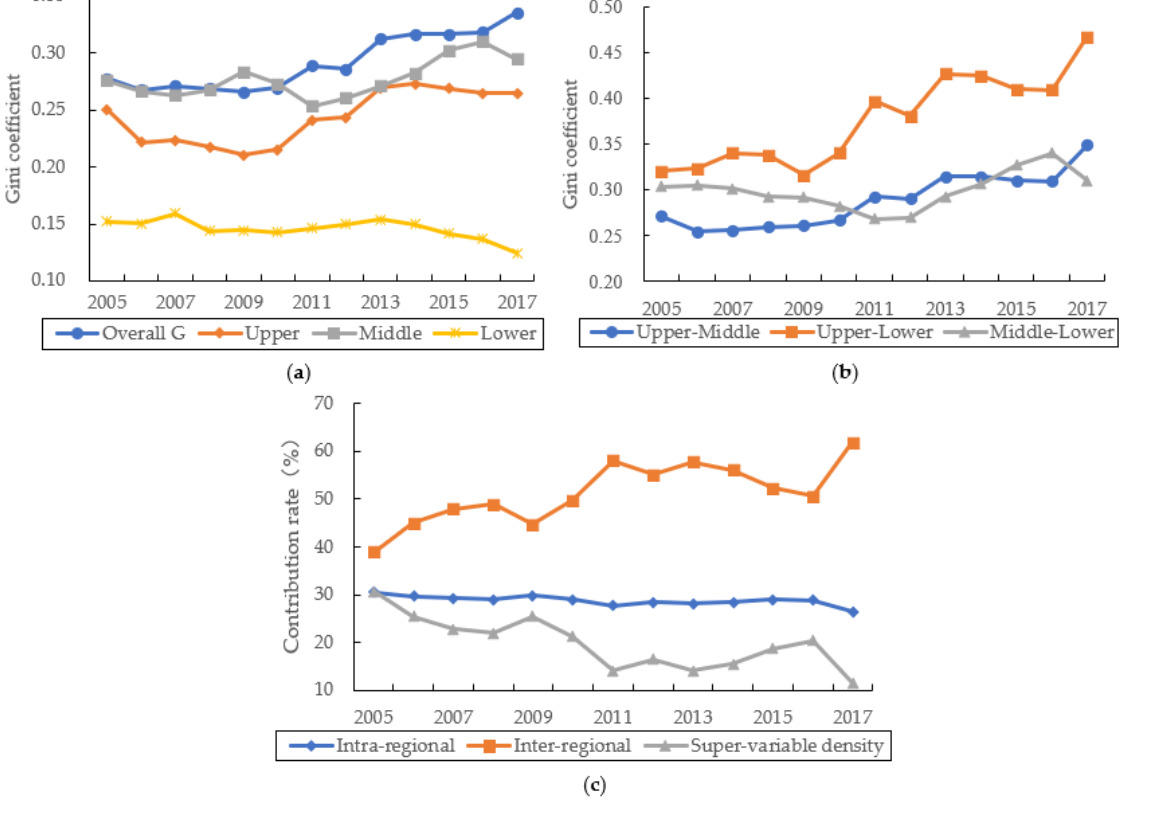
Figure 4. Magnitude and contribution rate of spatial differences in carbon emission intensity in the YRB. ( a ) Overall and intra ‐ regional Gini coefficients; ( b ) Inter ‐ regional Gini coefficient; ( c ) Source YRB. ( a ) Overall and intra-regional Gini coefficients; ( b ) Inter-regional Gini coefficient; ( c ) Source and and contribution rate of spatial differences. contribution rate of spatial